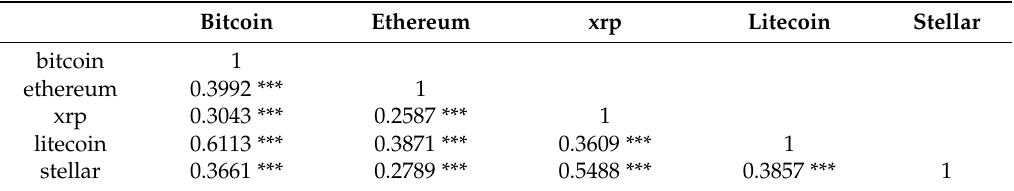
Table 2. Correlation